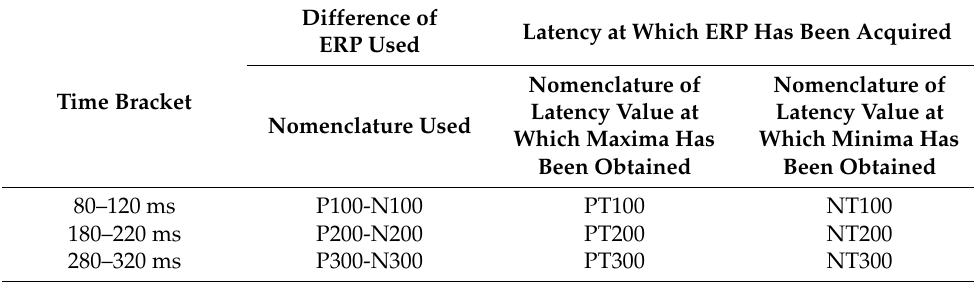
Table 3. The difference of ERP features obtained from average ERPs and corresponding